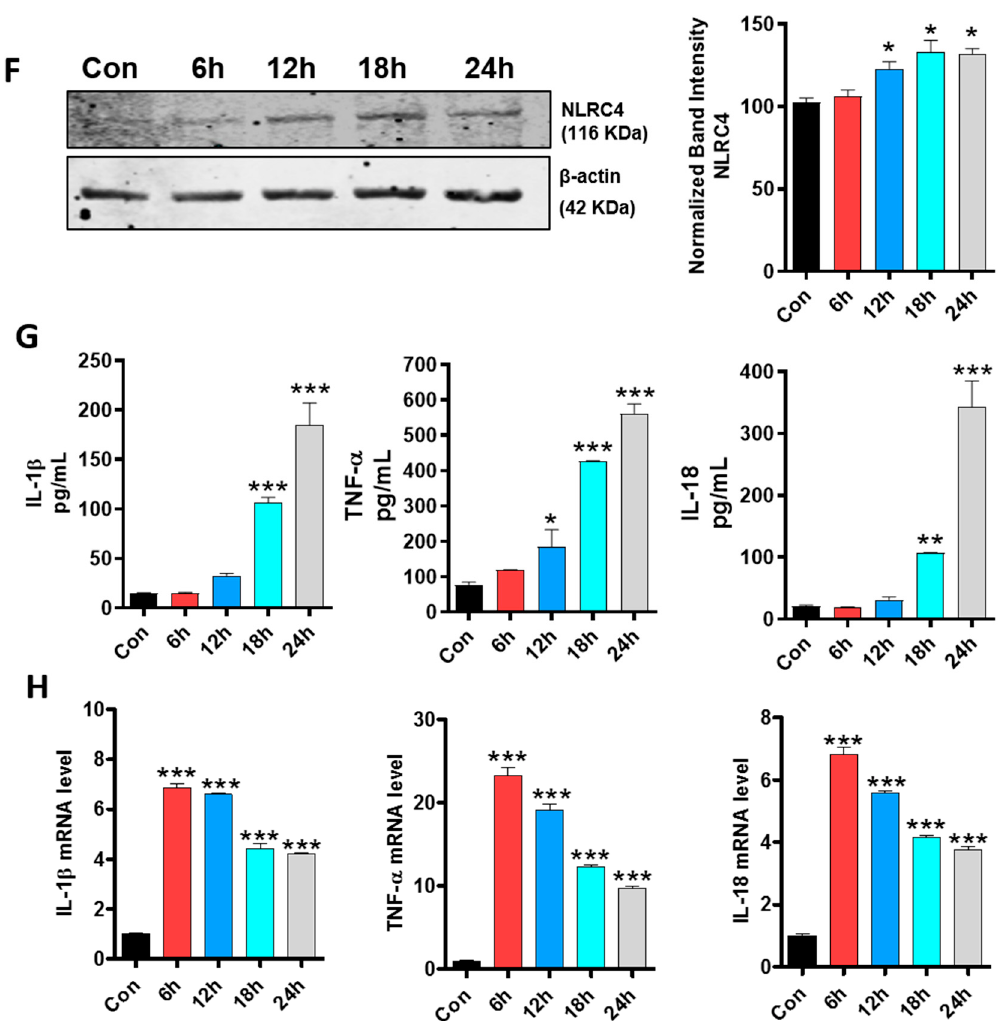
Figure 2. TWEAK-induced oxidative stress response and PKC δ and NLRC4 inflammasome activation concomitant with induction of proinflammatory markers in human astrocyte (U373) cells. (A-H) Human astrocyte (U373) cells were treated with TWEAK (100 ng / mL) for increasing time points (6 h, 12 h, 18 h and 24 h) and analyzed thereafter to evaluate the oxidative stress response. All immunoblots shown in this figure used β -actin as the loading control. ( A ) A MitoSox assay was performed by incubating U373 cells with 5 µ M MitoSox dye for 20 min post-TWEAK treatment, and the magnitude of mito ROS was quantified using a fluorescence microplate reader. MitoSox assay shows a time-dependent increase in the level of mitochondrial superoxide post-TWEAK treatment. Data shown are the mean ± SEM from at least three independent experiments. ( B ) Nitrite release assay showing a time-dependent increase in the level of nitric oxide post-TWEAK treatment as determined using the Griess reagent. Data shown are the mean ± SEM from at least three independent experiments. ( C ) ROS generation was measured using the redox-sensitive dye CM-H2DCFDA (1 µ M). ROS levels were significantly increased in a time-dependent manner post-TWEAK treatment, as demonstrated by DCF DA fluorescence plate reader analysis. Data shown are the mean ± SEM from at least three independent experiments. ( D ) Cell lysates post-TWEAK treatment were subjected to Western blot analyses for PKC δ and pPKC δ (Y311). Representative blots and densitometric evaluation show a time-dependent increase in PKC δ phosphorylation, indicative of activation post-TWEAK treatment, whereas the expression levels of parent PKC δ were comparable between TWEAK- and vehicle-treated U373 cells. Data shown are the mean ± SEM from at least three independent experiments. ( E ) WB analysis of STAT3 activation in U373 cells treated with TWEAK for 24 h. Representative immunoblots reveal a marked increase in p -STAT3 expression levels, but not STAT3 levels, in TWEAK-treated cells. Band quantification using densitometric scanning analysis demonstrated elevated expression of p -